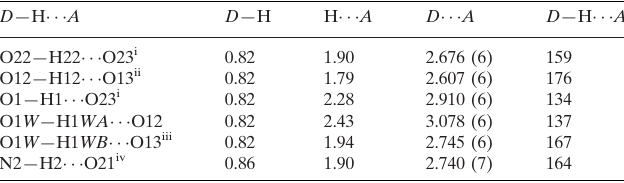
Hydrogen-bond geometry (A˚ , (cid:4) ). D —H (cid:3)(cid:3)(cid:3)